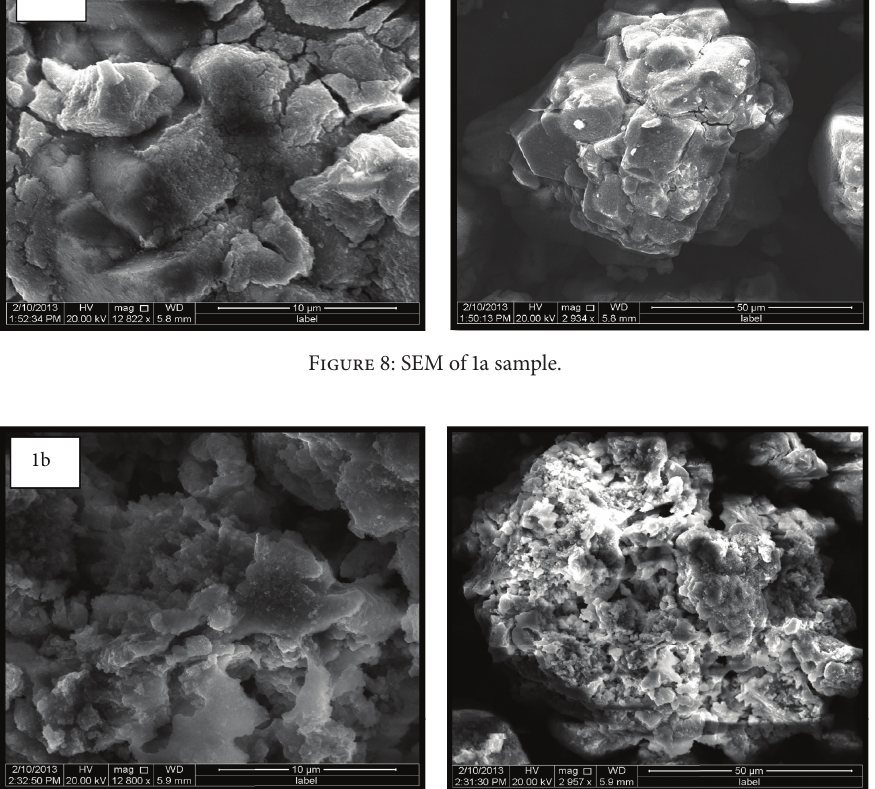
Figure 9: SEM of 1b sample.